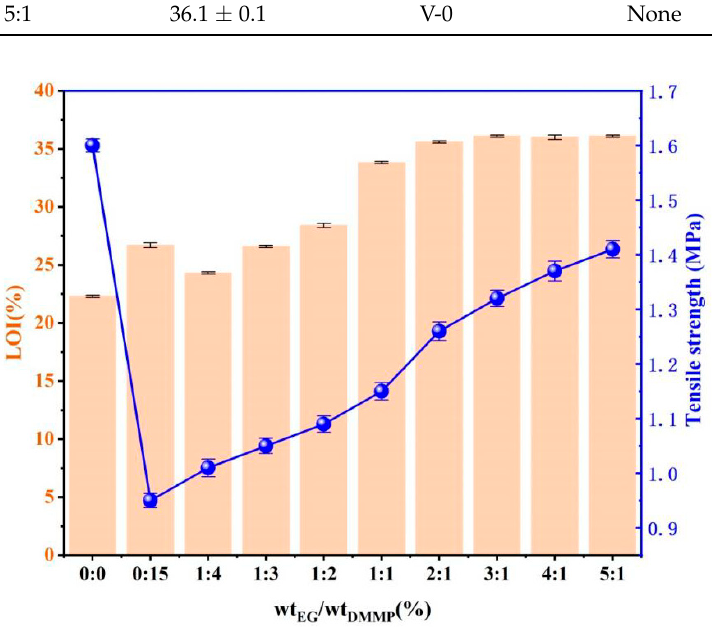
Figure 4. LOI and tensile strength of MPUE/EG/DMMP with different EG/DMMP ratios.